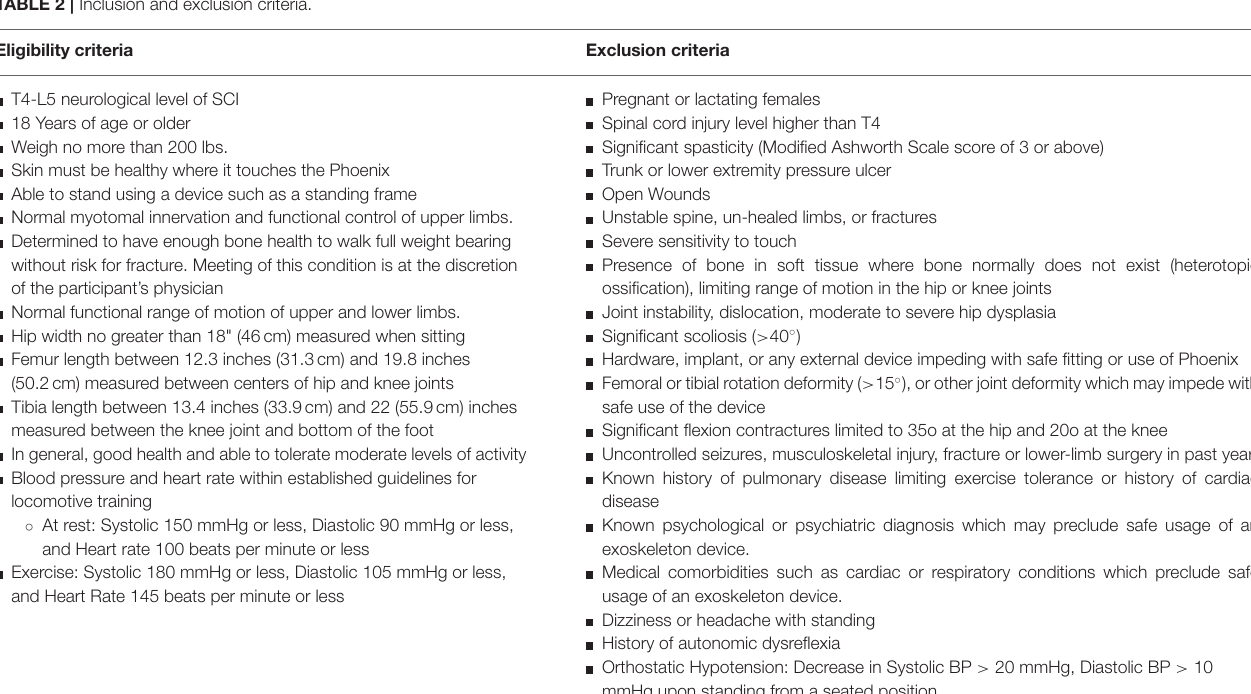
TABLE 2 | Inclusion and exclusion